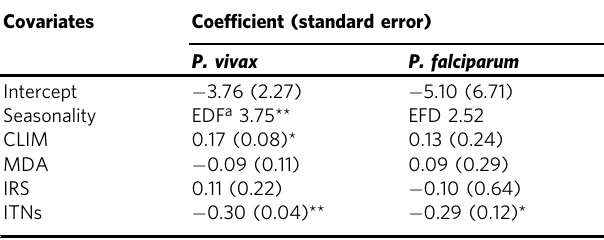
Table 1 Parameter estimates included in the negative binomial regression